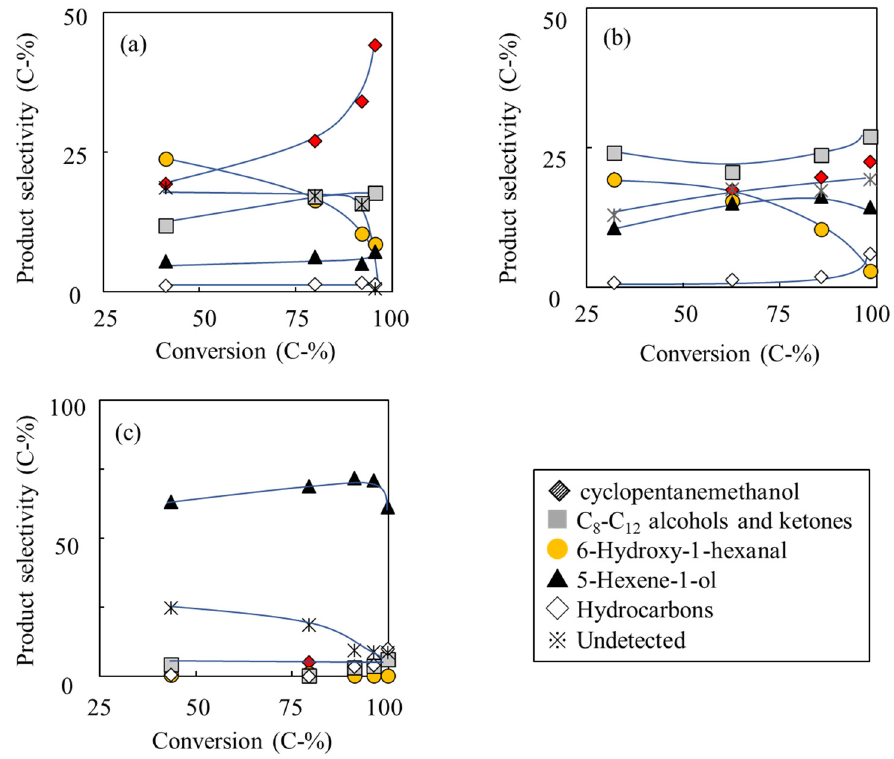
Figure 3. Relation between products selectivity and 1,6-hexanendiol conversion over Ca-HAP catalysts with various Ca/P molar ratios: ( a ) Ca-HAP(1.72), ( b ) Ca-HAP(1.62), and ( c ) Ca-HAP(1.54). Temperature 375 ◦ C; 1,6-hexanediol 10 mol% EtOH solution, 1 mL h − 1 ; N 2 , 30 mL min − 1 . Conversion and selectivity were averaged for the initial 3–5 h.